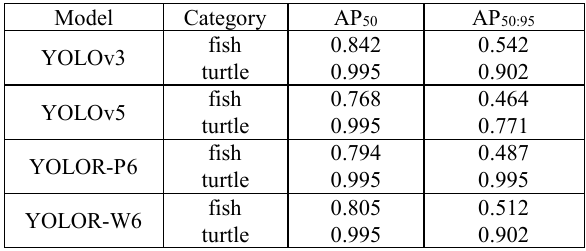
Table 2 . Precision of three